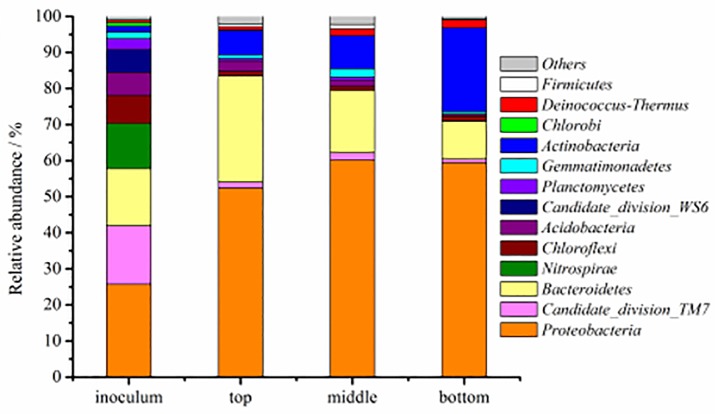
Abundances and distributions of the different phyla in the four biofilm samples.